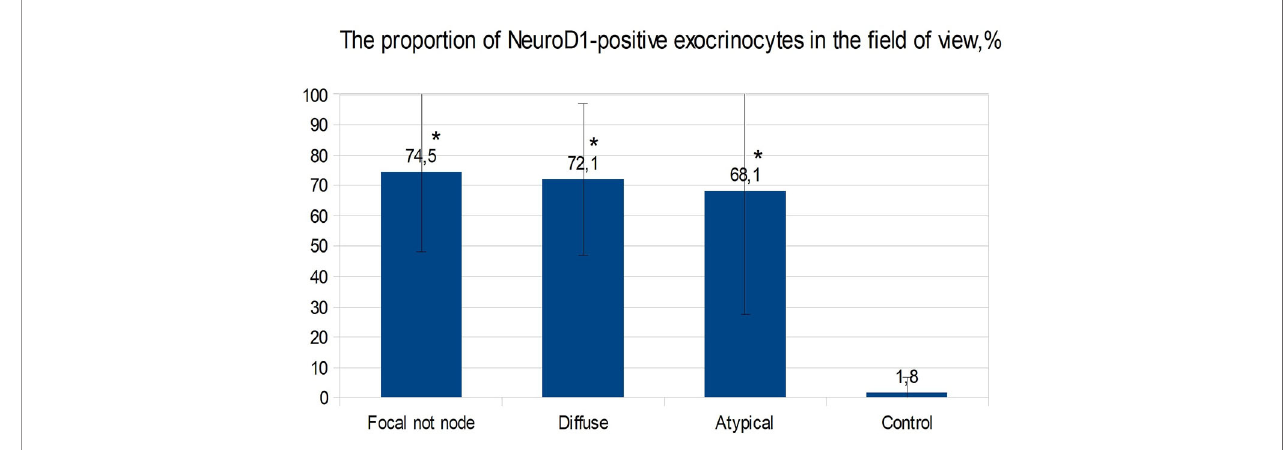
FIGURE 11 | The proportion of exocrinocytes expressing NeuroD1 in the fi eld of view in various forms of congenital hyperinsulinism. Data are presented as M ± SD. (*) - the difference compared to the control is statistically signi fi cant at p <0.01.